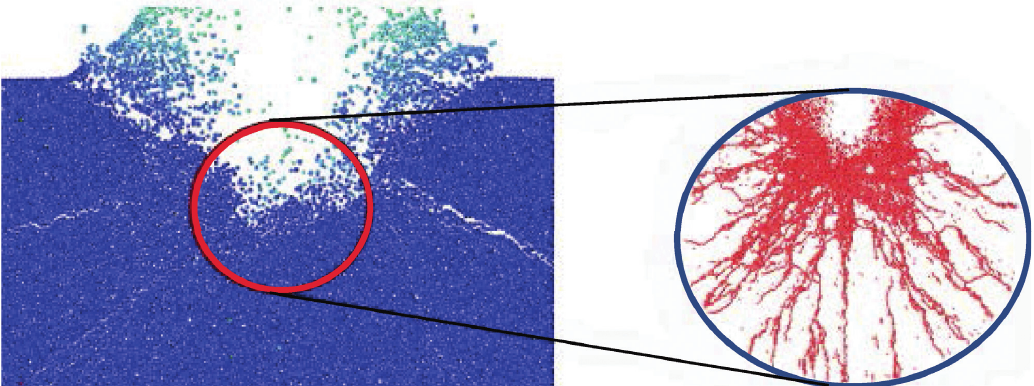
Figure 8: Spherical charge blasting crater and rock cracks.